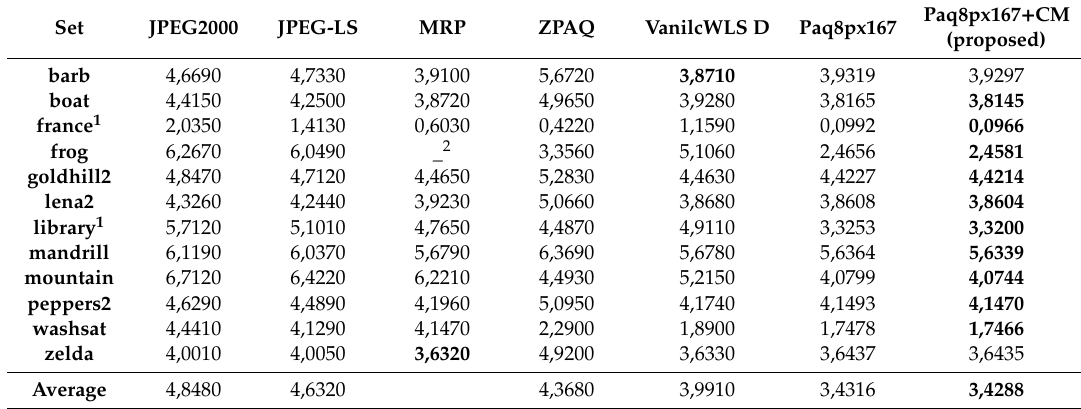
Table 2. Waterloo gray test set 2.